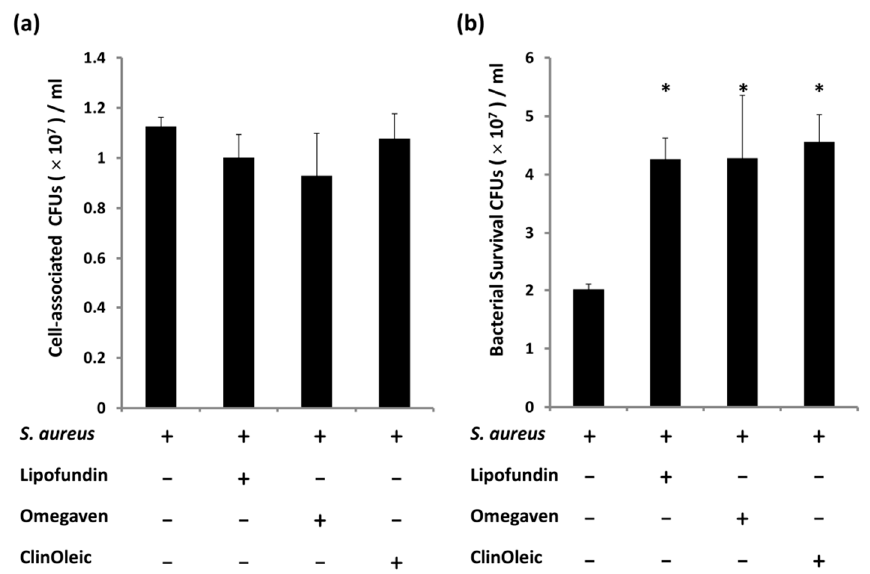
Figure 1. Treatment with lipid emulsions increased S. aureus survival in RAW264.7 cells. ( a ) The cell-associated colony-forming units (CFUs) at the start of infection (0 h). ( b ) Bacterial survival at the end of infection (3 h). The three lipid emulsions (60 μ g/mL) were used to treat cells prior to and during S. aureus infection. After bacterial adherence for 30 min, the cells were washed with 1× PBS, and the cell-associated CFUs were counted at this time. The rest of the cells were incubated with a medium supplemented with lipid emulsions, and the bacterial survival CFUs were counted after 3 h. The data are shown as the means ± SD of three individual experiments. Significance was analyzed by one-way ANOVA followed by Bonferroni test ( p < 0.05). * A significant difference compared with the S. aureus -infected control.